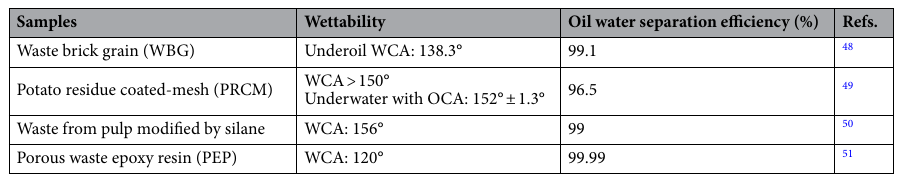
Table 1. Comparison of the wettability and oil–water separation performances for the HHF-PODS with the sample in references.